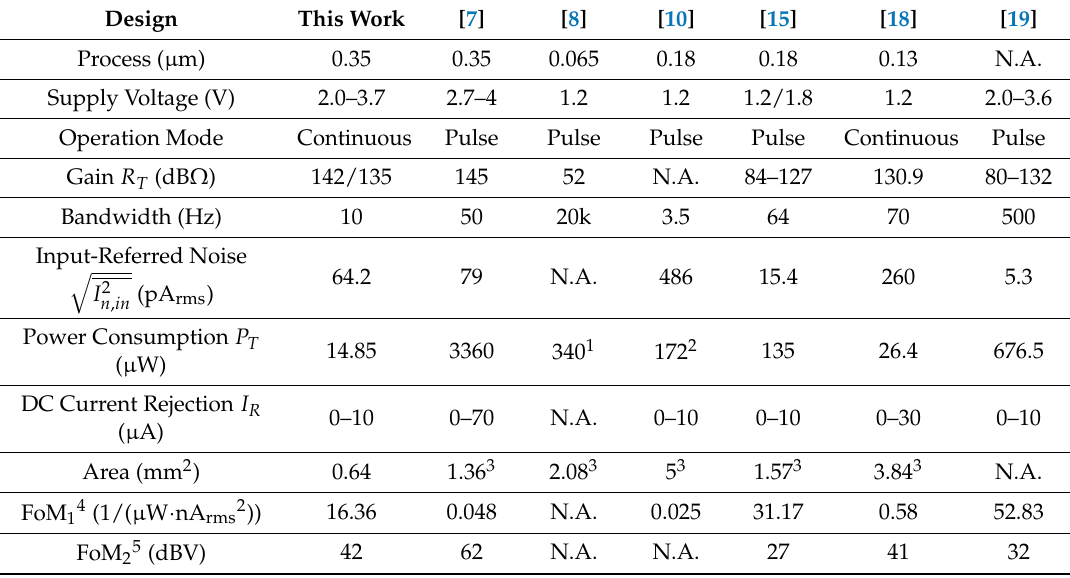
Table 1. The comparison with recently published